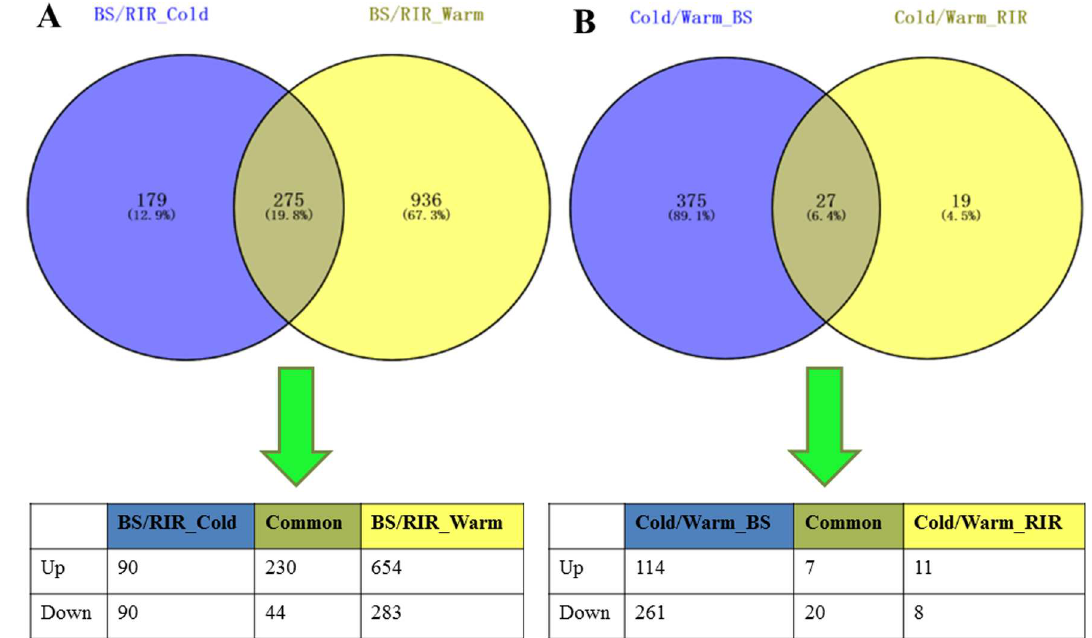
Fig 3. Venn diagrams. (A) Venn diagram for DEGs of BS/RIR_Cold and BS/RIR_Warm. One common significant gene, which was regulated at different directions in the two comparisons, was counted in the respective comparisons (bottom panel). (B) Venn diagram for DEGs of Cold/Warm_RIR and